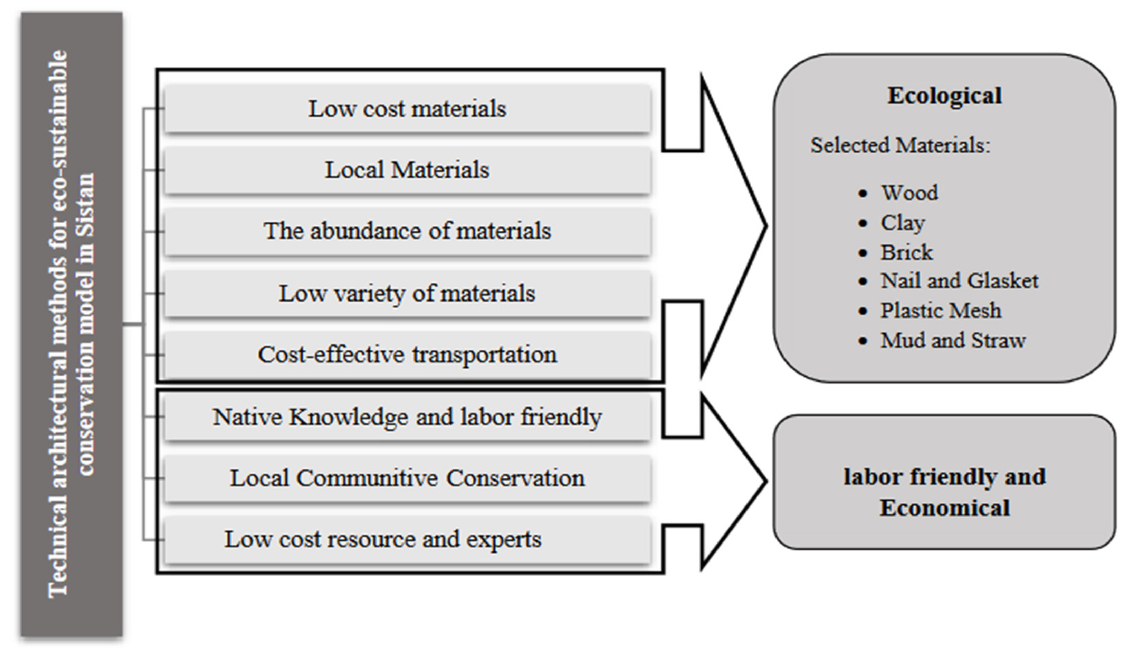
Figure 3. Technical architectural methods for eco-sustainable conservation model in Sistan.